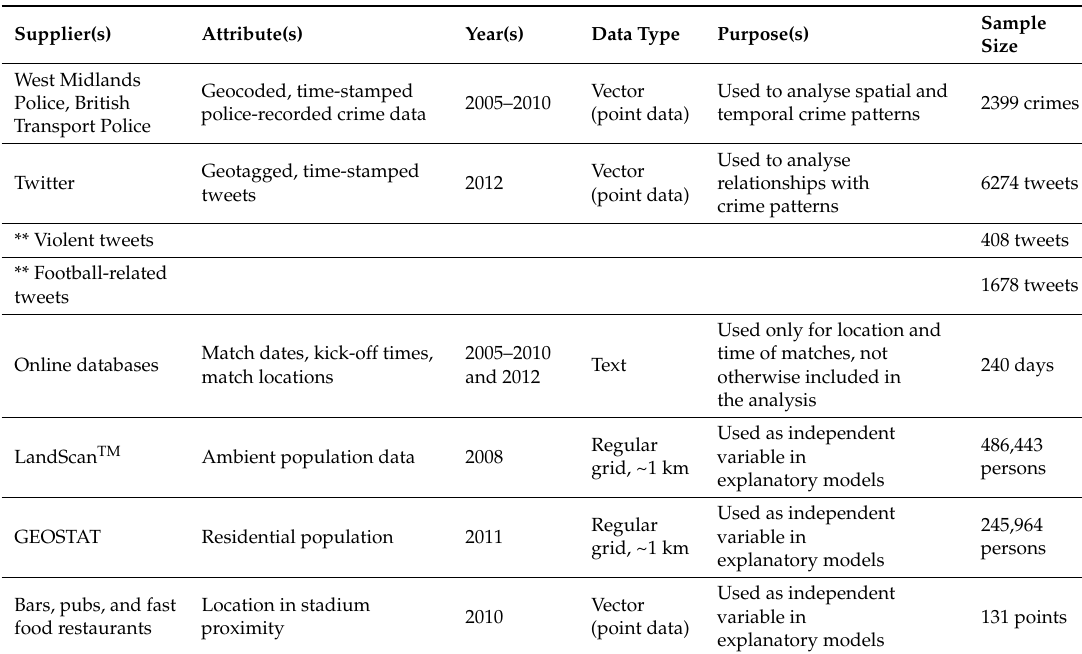
Table 1. Summary of datasets used in this study (** subsets of all collected geotagged